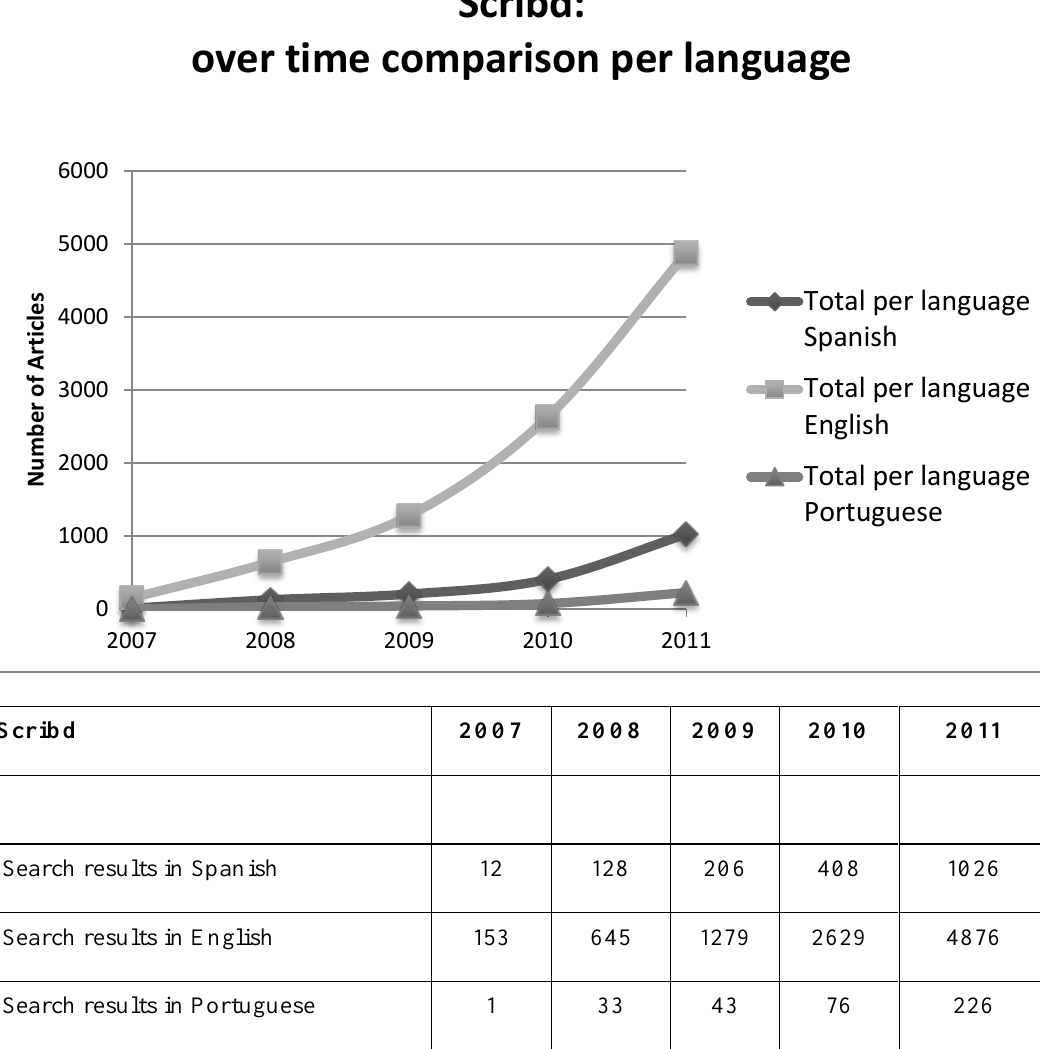
Figure 3 . Scribd: Over time comparison per language